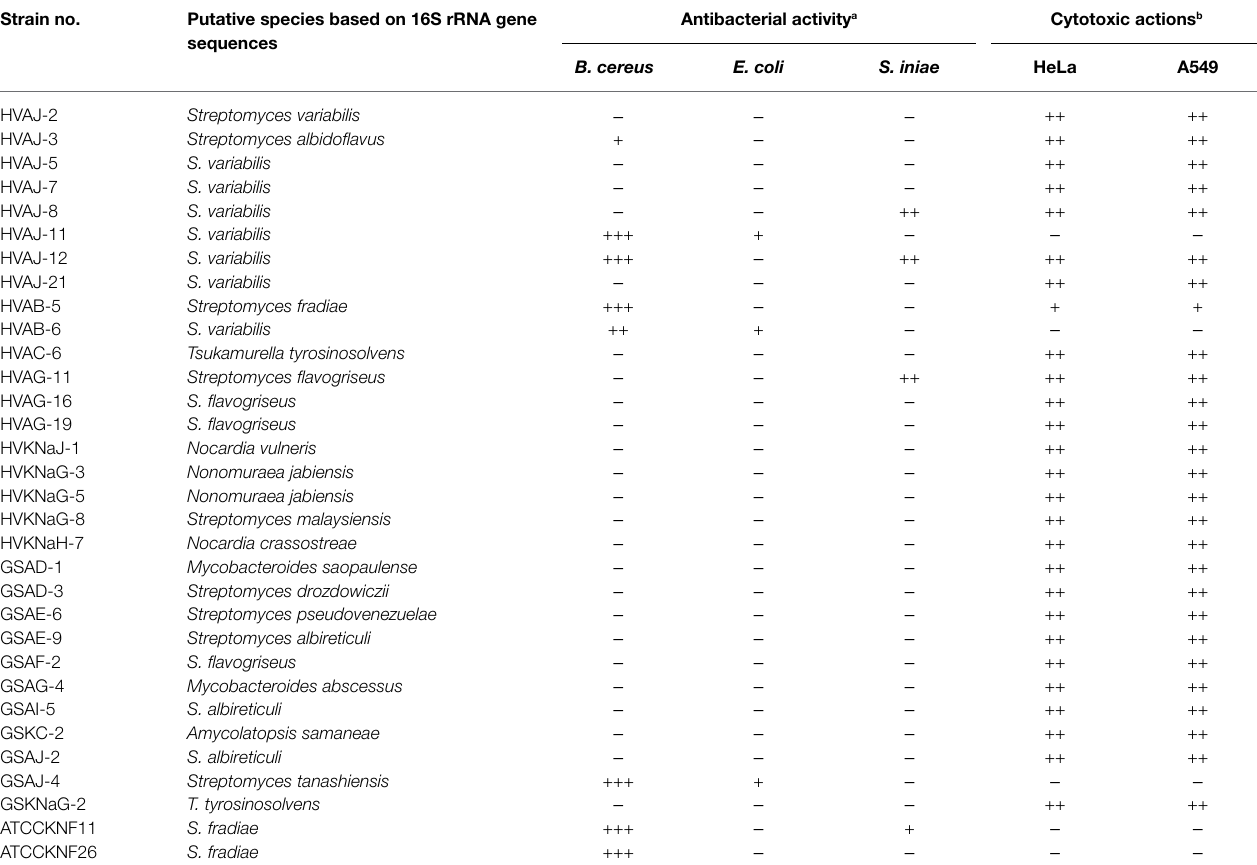
TABLE 1 | Antibacterial and cytotoxic activity of actinobacterial strains isolated from soils of the Weizhou and Xieyang Islands. Strain